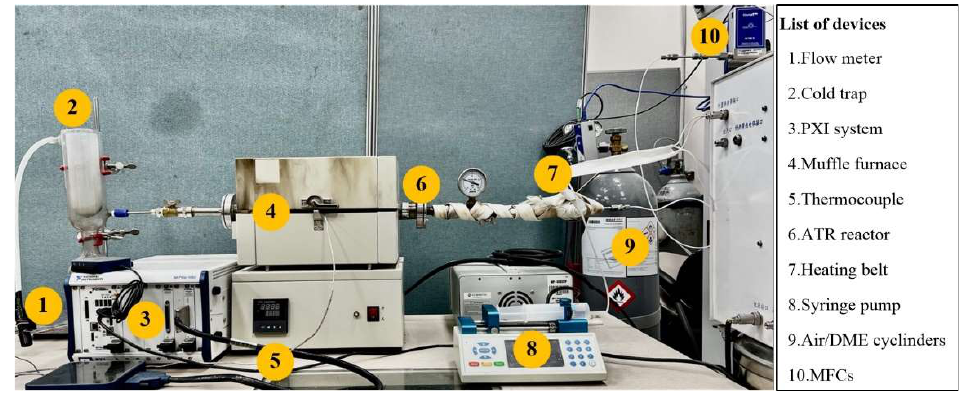
Figure 4. Hydrogen generation system prototype.